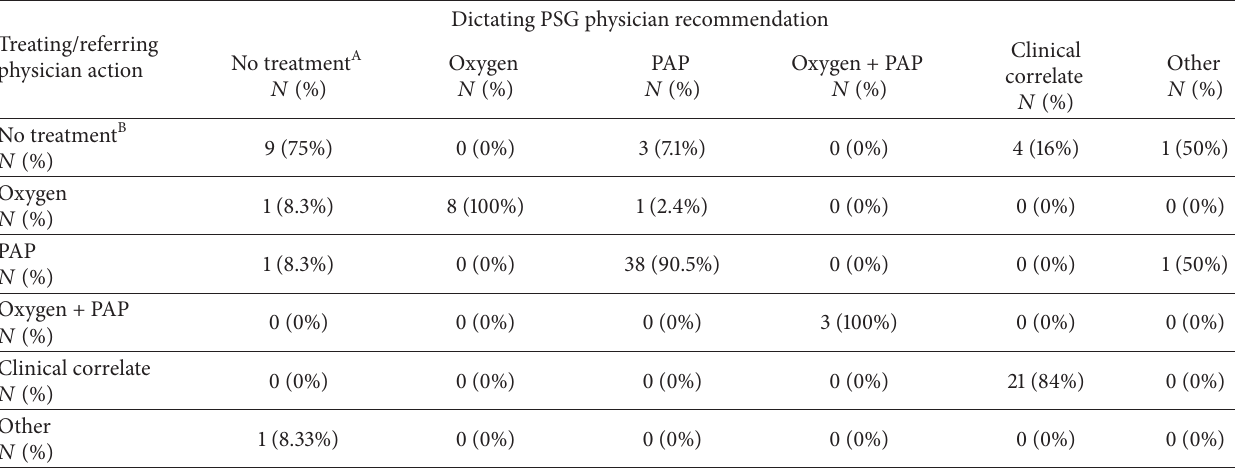
A Table 3 when read in the vertical direction shows the dictating PSG physician recommendations. The no treatment column indicates that of the total 12 patients who were recommended no treatment, 9 patients (75 % ) received no treatment, 1 patient received oxygen, 1 patient received PAP, and 1 patient received other therapy. B The table read in the horizontal direction indicates the treating/referring physician’s action. For the no treatment group, 9 patients received no treatment (75 % ) correlating with what was recommended. No patients in the oxygen group ended in the no treatment group. Three patients in the PAP group received no treatment. No patients in the oxygen + PAP group ended in the no treatment. Four patients in the clinical correlate group received no treatment and 1 patient in the other group received no